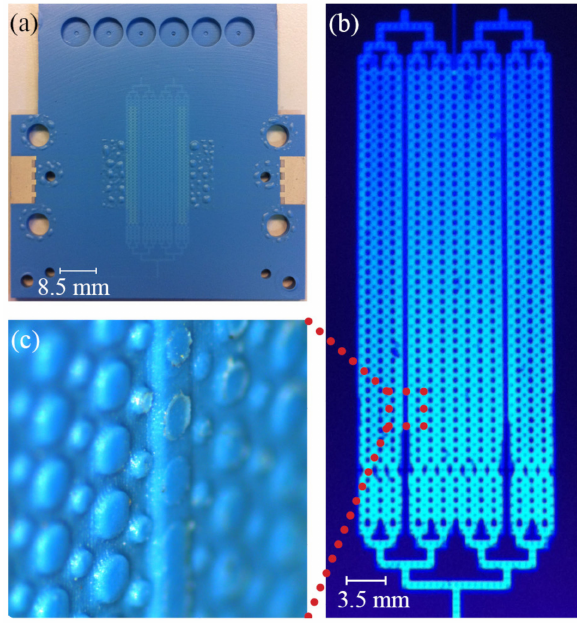
Figure 2. Monolithic ceramic µ FFE device design and fabrication. ( a ) Image of the µ FFE device. ( b ) Fluorescence image of the µ FFE device filled with 4MU solution. ( c ) Open microfluidic chamber image, fabricated using a multilevel design, showing the 10 um deep shallower side channels which separate the 60 um deep electrode chamber from the 60 um deep separation